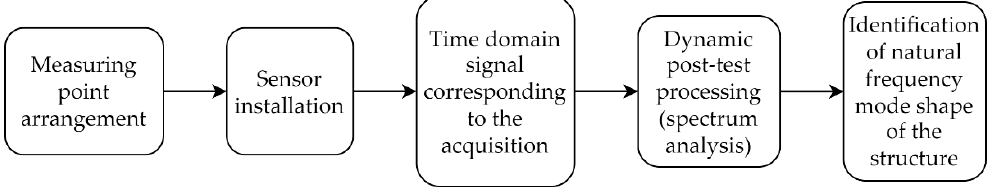
Figure 3. Environmental excitation method flow chart.